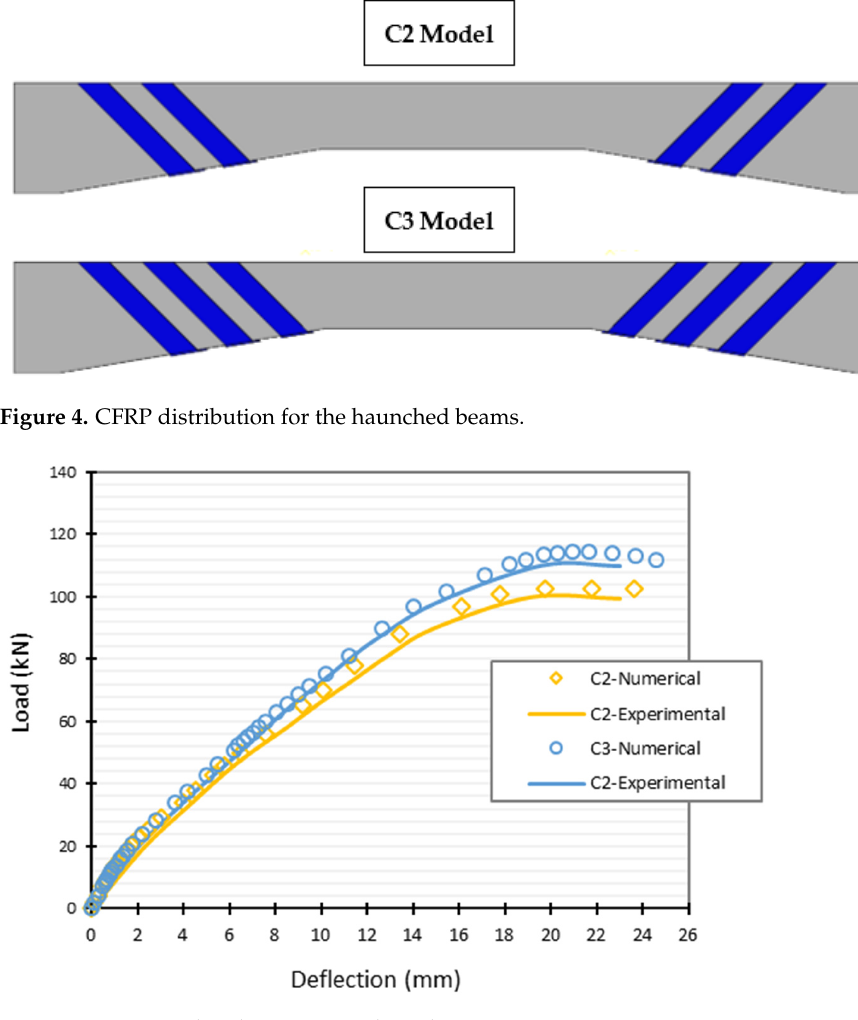
Figure 5. Numerical and experimental results comparison.